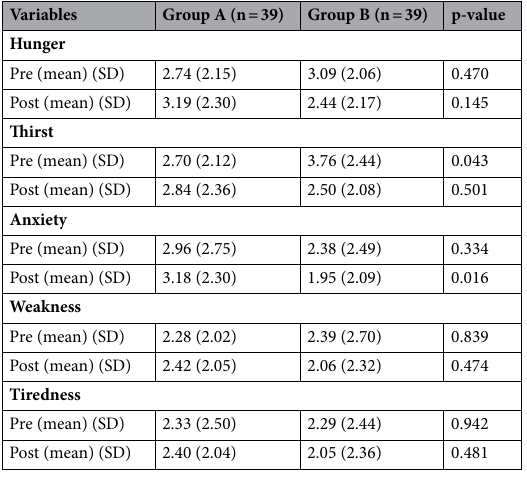
Table 2. Unadjusted mean for VAS measurement for participants’ well-being.